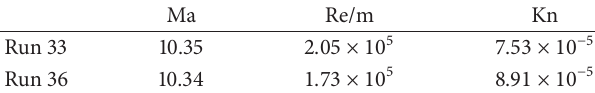
Figure 15: DSMC simulation of Run number 33 ( 𝐶 𝑃 ). Table 4: Flow conditions for Run Numbers 33 and Numbers 36.